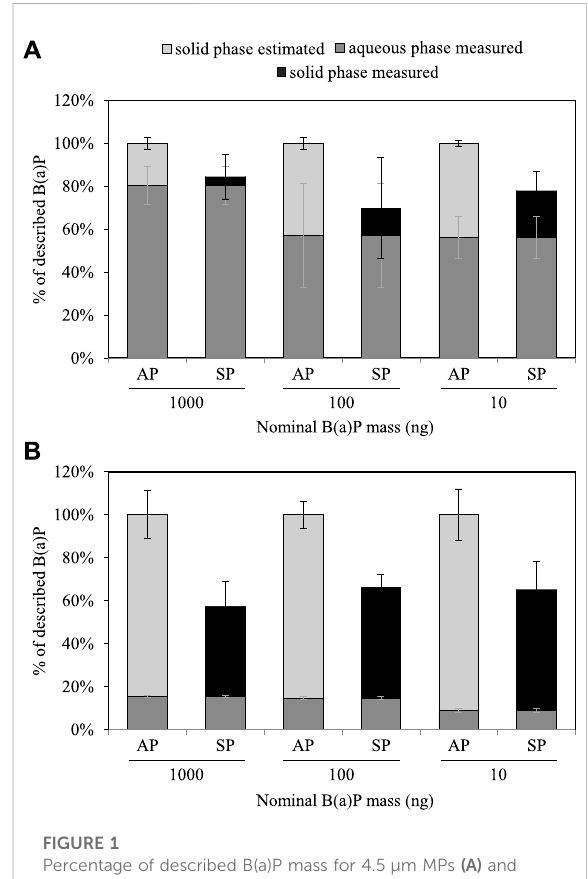
FIGURE 1 Percentage of described B(a)P mass for 4.5 μ m MPs (A) and for 0.5 μ m MPs (B) according to measurements carried out in the aqueous phase (AP) or in aqueous and in solid phases